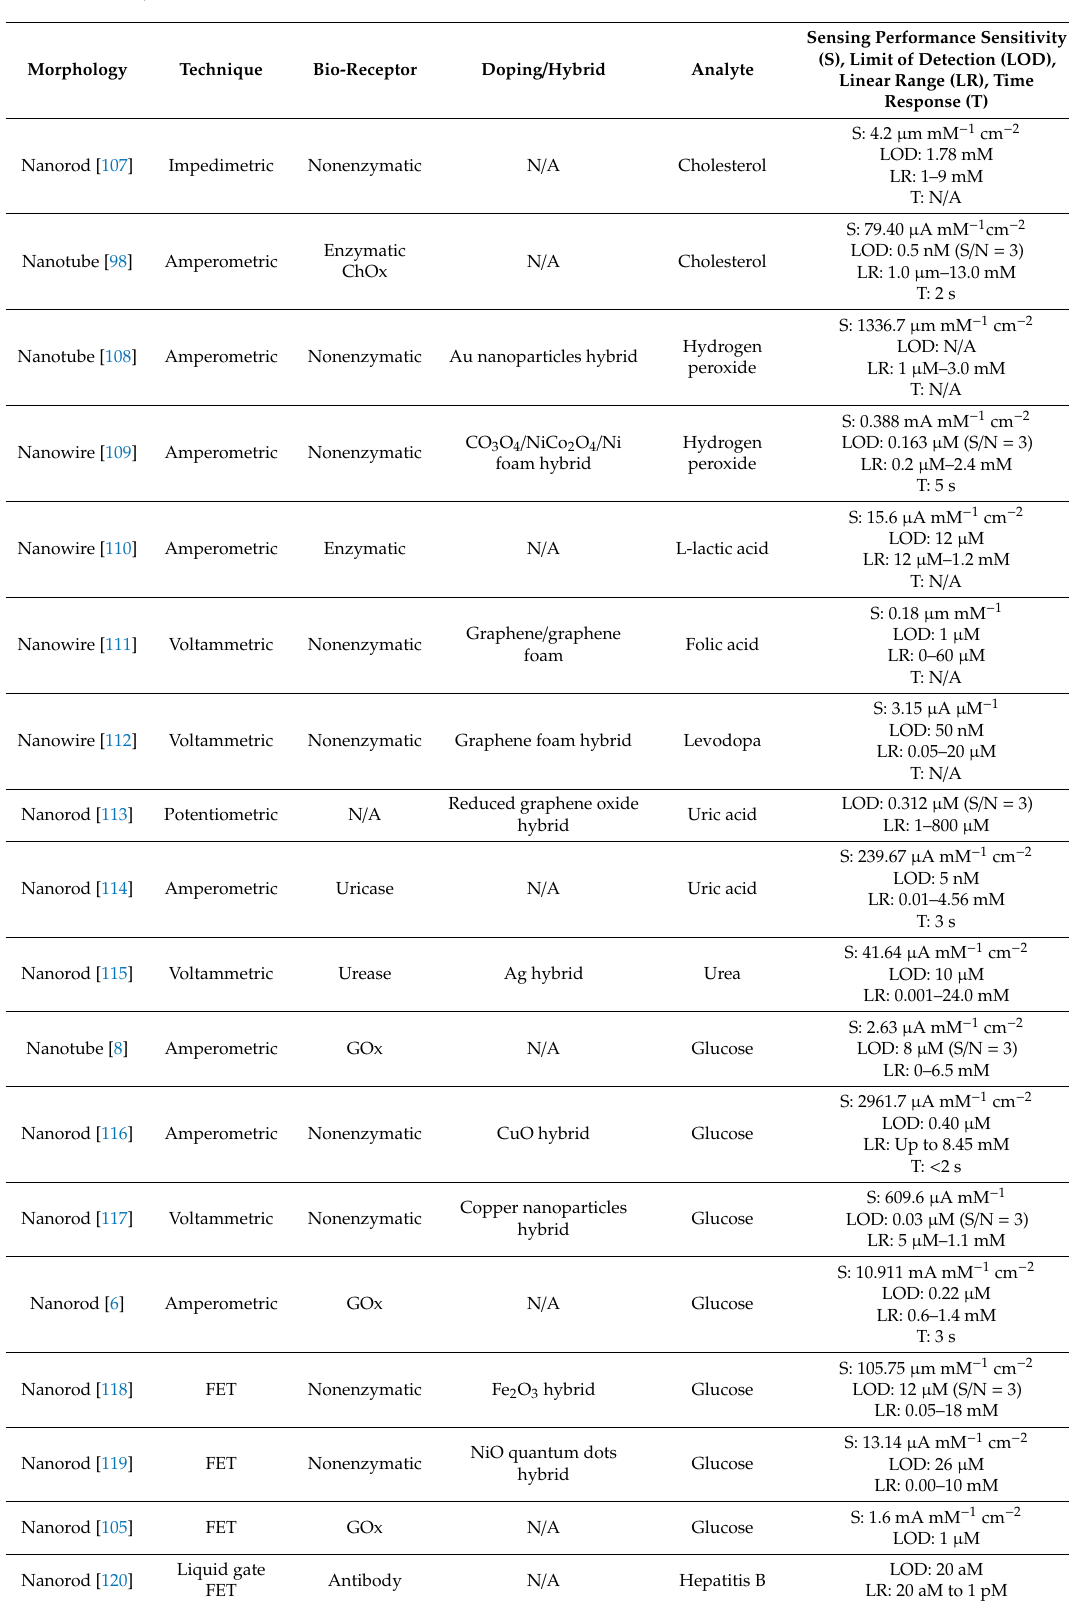
Table 2. Di ff erent techniques of 1-D ZnO-based electrochemical biosensors for various analyte detections, since